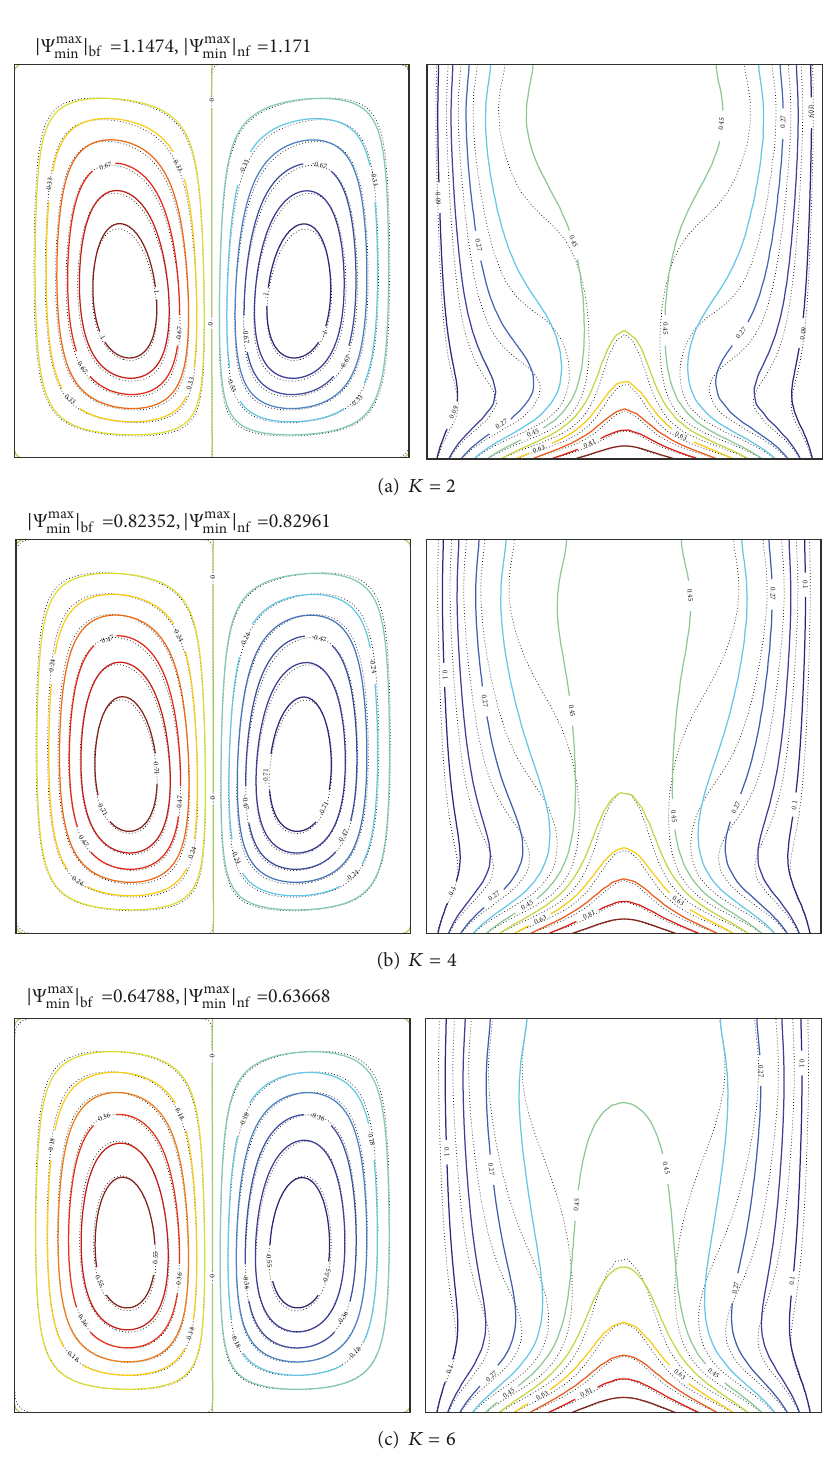
Figure 5: Streamlines and isotherms evolutions of nanoliquid (solid lines) and base liquid (dashed lines) by varying the material parameter for discontinuous heating corresponding to case 2 at 𝐺 = 1.0